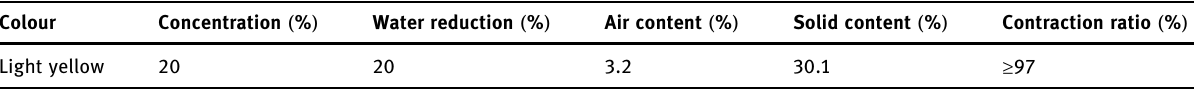
Table 3: Properties of the superplasticiser provided by the manufacturer Colour Concentration ( % ) Water reduction ( % ) Air content ( % ) Solid content ( % ) Contraction ratio ( % ) Light yellow